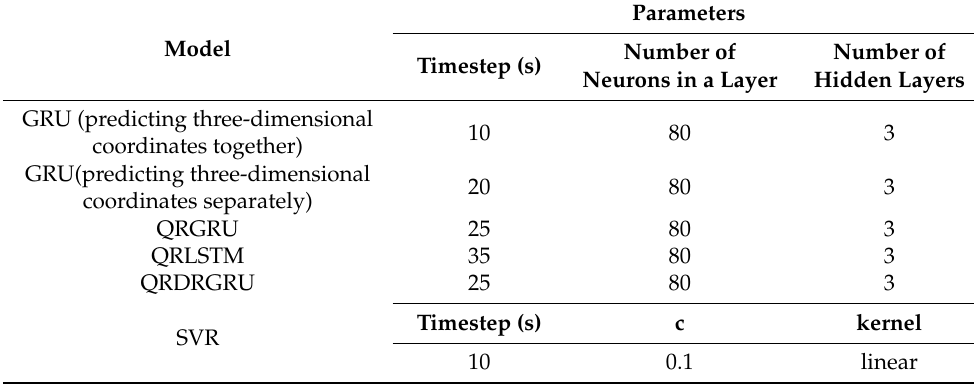
Table 5. The hyperparameters for the models.